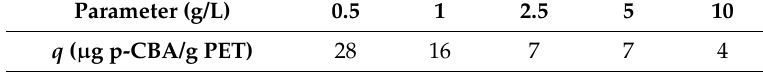
Figure 3. Charge of p‐CBA in ionization equilibrium. Table 3. Adsorption loading of p‐CBA ( C ο = 4 μM) onto the TMFx catalysts ( C TMFx = 0.5 mg/L).